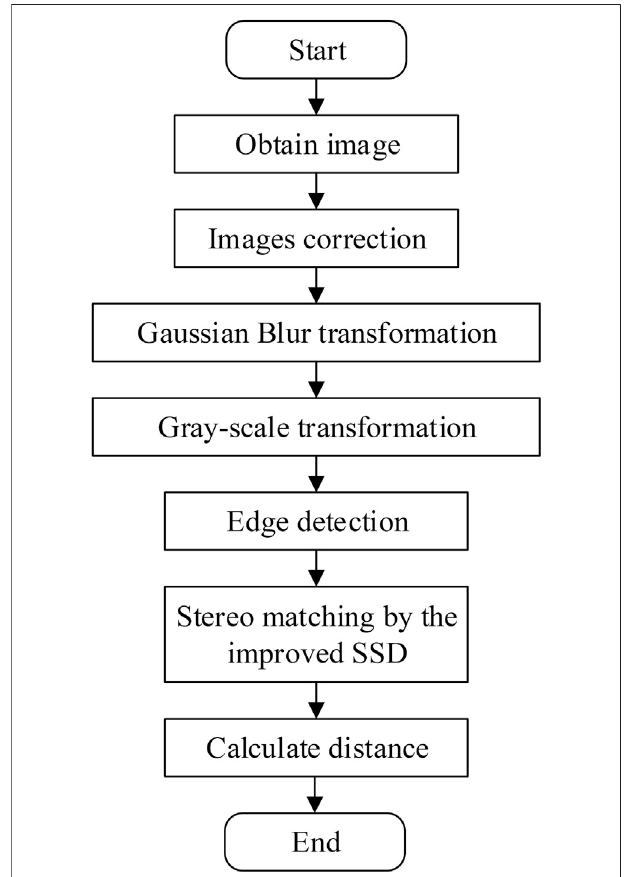
FIGURE 2 | | System processing fl ow